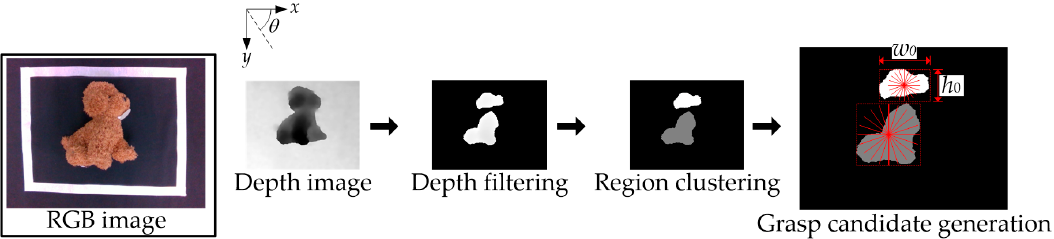
Figure 3. Operation of the grasp candidate generator.